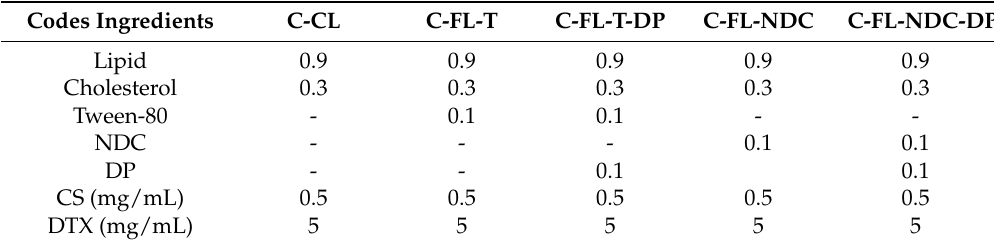
Table 2. The composition of docetaxel (DXT)-loaded chitosomes. C—chitosan-coated. Codes Ingredients